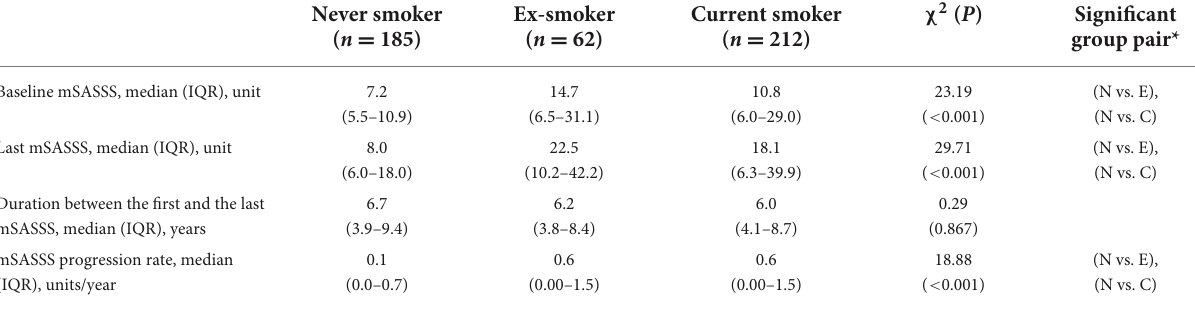
TABLE 3 Differences in mSASSS and mSASSS progression rate according to smoking